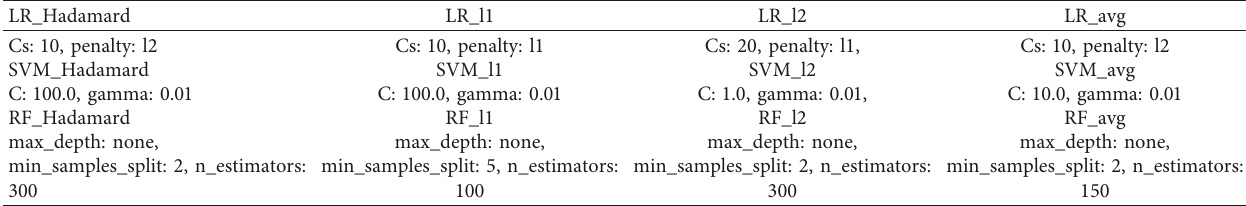
Table 13: Utilizing the obtained embeddings for nodes and links through Node2Vec, best hyperparameters for LR, SVM, RF models, for quoting interaction April 12 until April 22 in 2021 1 .